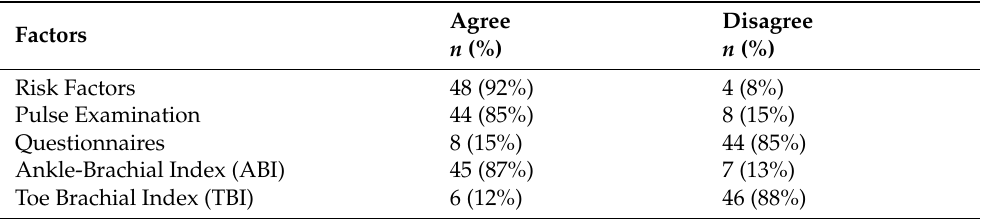
Table 3. Results for question, “Which of the following do you consider important in diagnosing PAD?” ( n =